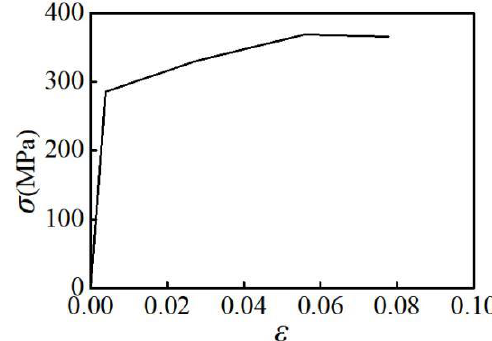
Figure 10. Finite element model: (a) boundary conditions of the model; (b) mesh generation of parallel section; (c) mesh generation of clamping section.